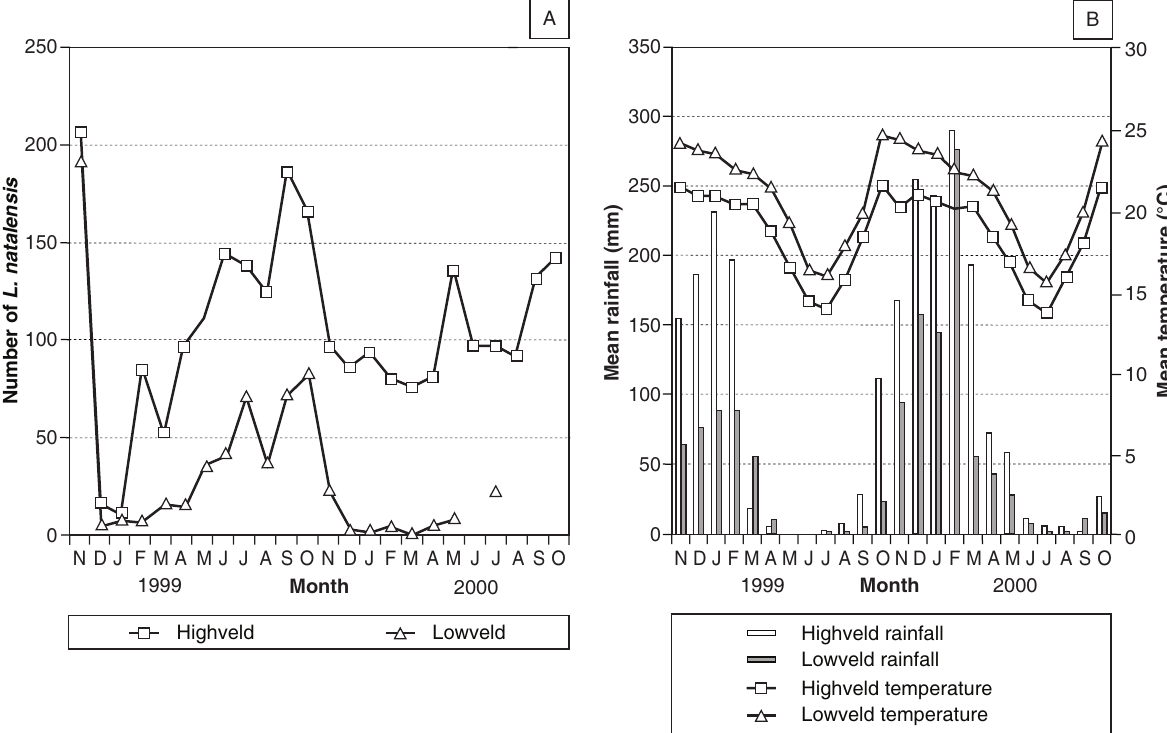
FIG. 3 Monthly variation of Lymnaea natalensis in the highveld and lowveld (A), and mean monthly rainfall and temperature in the highveld and lowveld (B) communal grazing areas of Zimbabwe sampled for the period November 1998 to October